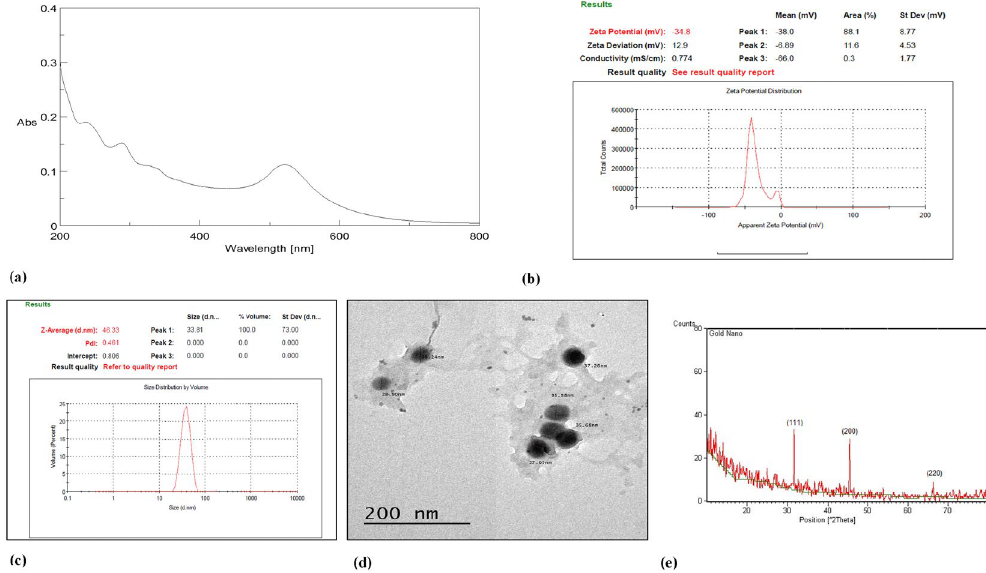
Figure 1. The UV spectrum ( a ) zeta potential ( b ) particle size and particle size distribution ( c ) transmission electron microscopy ( d ) and X-ray diffraction ( e ) of formed gold nanoparticles (AuNPs).